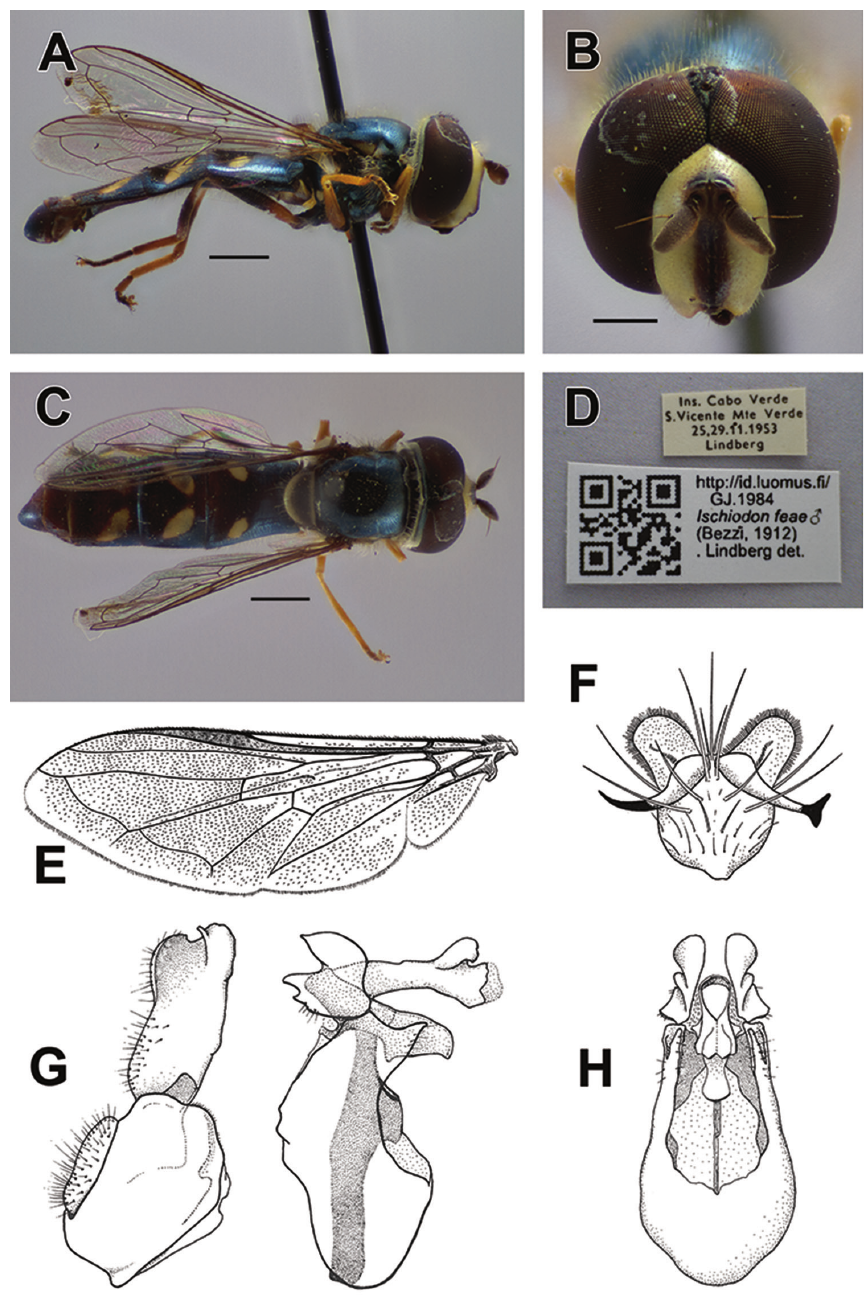
Figure 5. Ischiodon feae (Bezzi), male http://id.luomus.fi/GJ.1984: A Habitus, lateral view B Frontal view C Habitus, dorsal view D Labels E Wing F Acropod and fifth tarsomere of the fore leg, dorsal view G Male genitalia, lateral view H Hypandrium, ventral view. ( E–H from Claussen and Barkemeyer 1987). Scale bars: 1